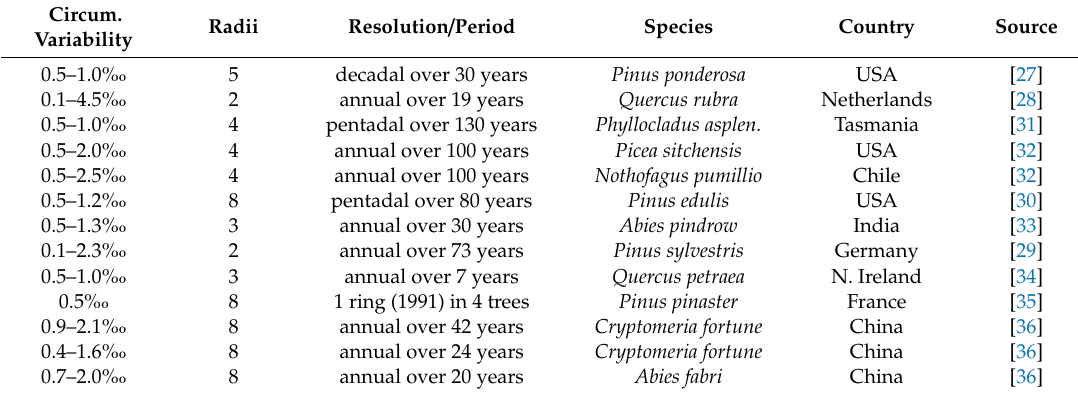
Table 1. Circumferential δ 13 C variability in tree-ring studies. The first column lists the ranges of smallest to largest δ 13 C di ff erences among years (pentads or decades) for which radial isotope values were measured in the respective